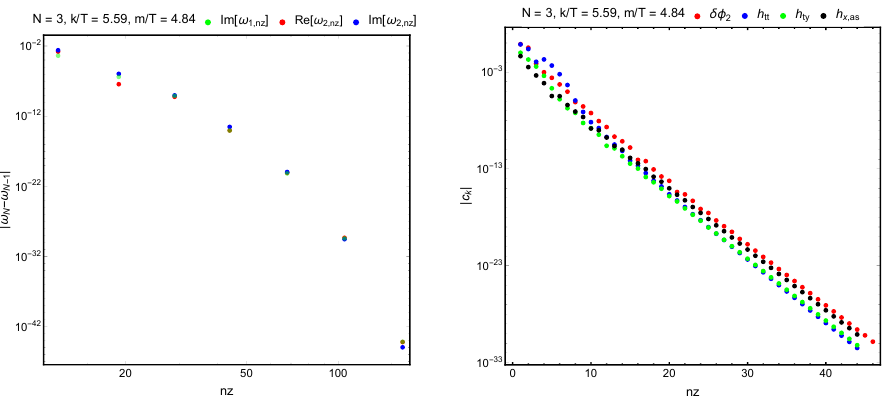
Figure 14 . Left: moving of the lowest three QNMs with increasing grid size. Right: Chebychev- coe(cid:14)cients of the eigenfunctions corresponding to the second lowest